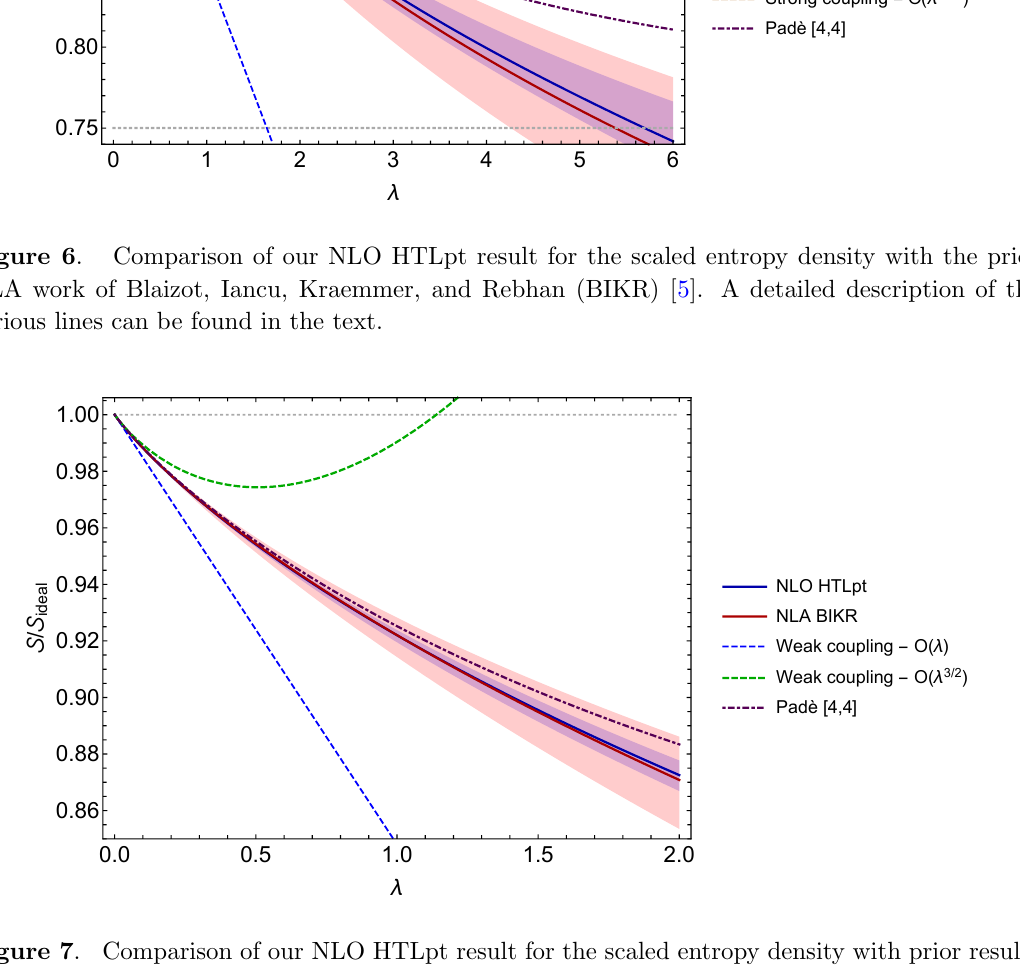
Figure 7 . Comparison of our NLO HTLpt result for the scaled entropy density with prior results at small (cid:21) . Lines are the same as in (cid:12)gure